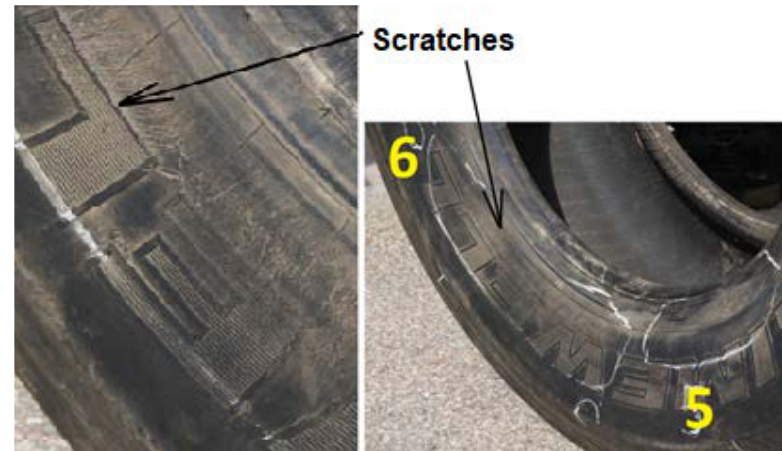
Figure 6. Scratches on the inner side of the tire (near the bead).